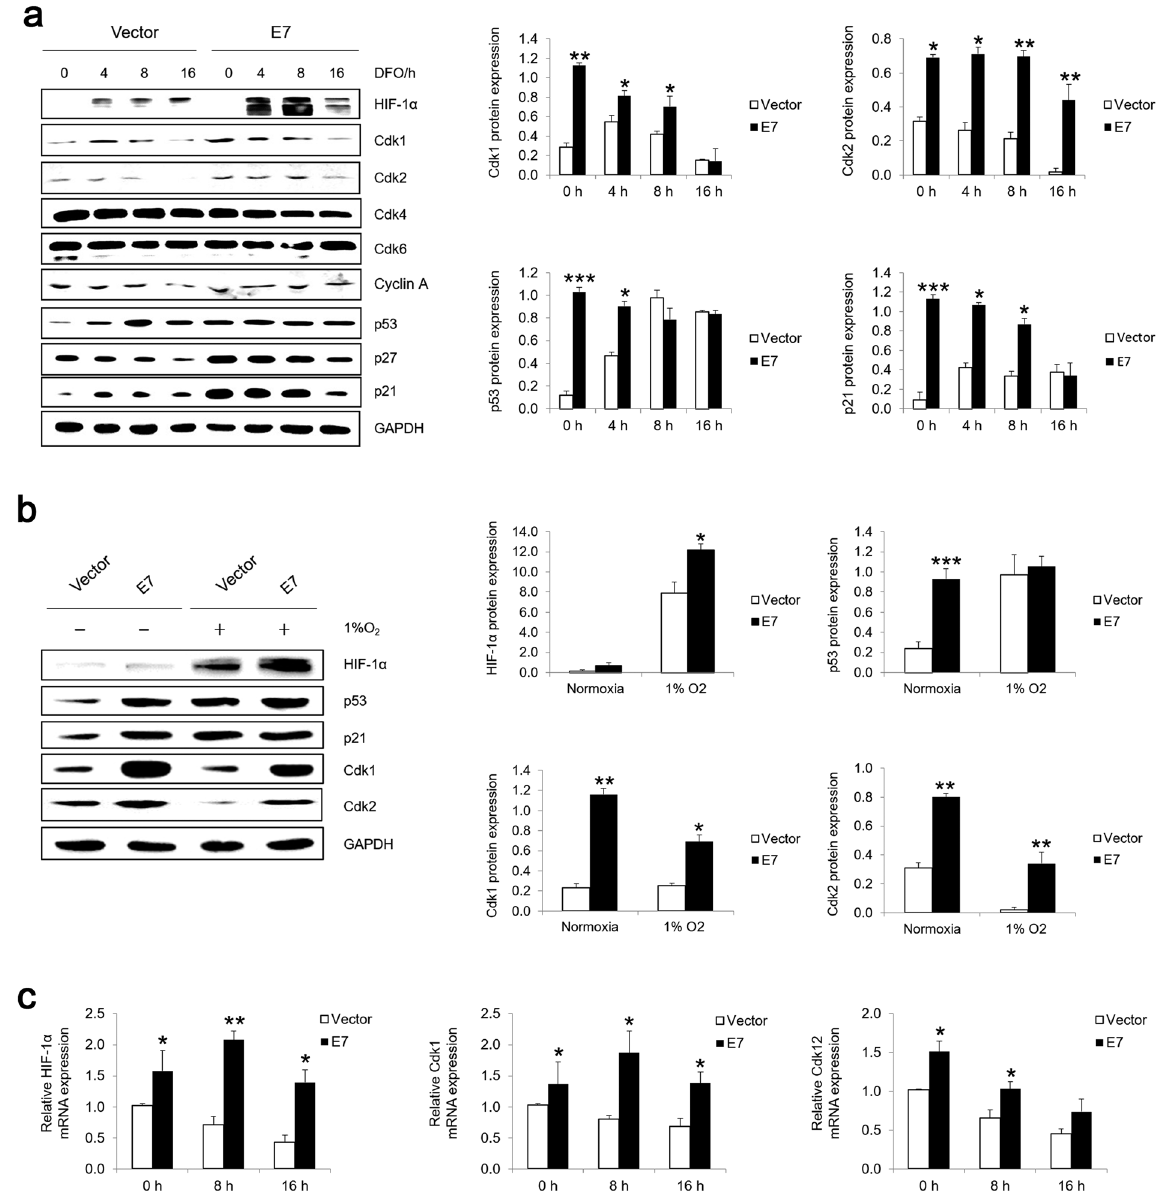
p53, p21, p27, Cdk1, Cdk2, Cdk4, Cdk6 and cyclinA in RPE1 cells treated with 200 μ M DFO ( a ) or 1% O 2 chamber ( b ) were examined by immunoblotting (Left panels) (original blots are presented in Supplementary Figure 2) and quantified (Right panels). A representative of 3 independent experiments is shown. ( c ) The mRNA level of HIF-1 α , Cdk1 and Cdk2 were detected by RT-qPCR. GAPDH was used as a control. * P < 0.05; ** P < 0.01; *** P <